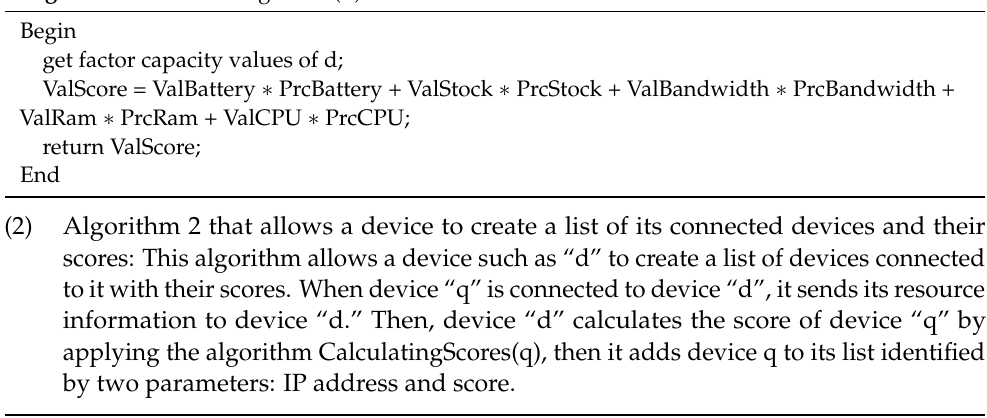
Algorithm 1. CalculatingScores(d)